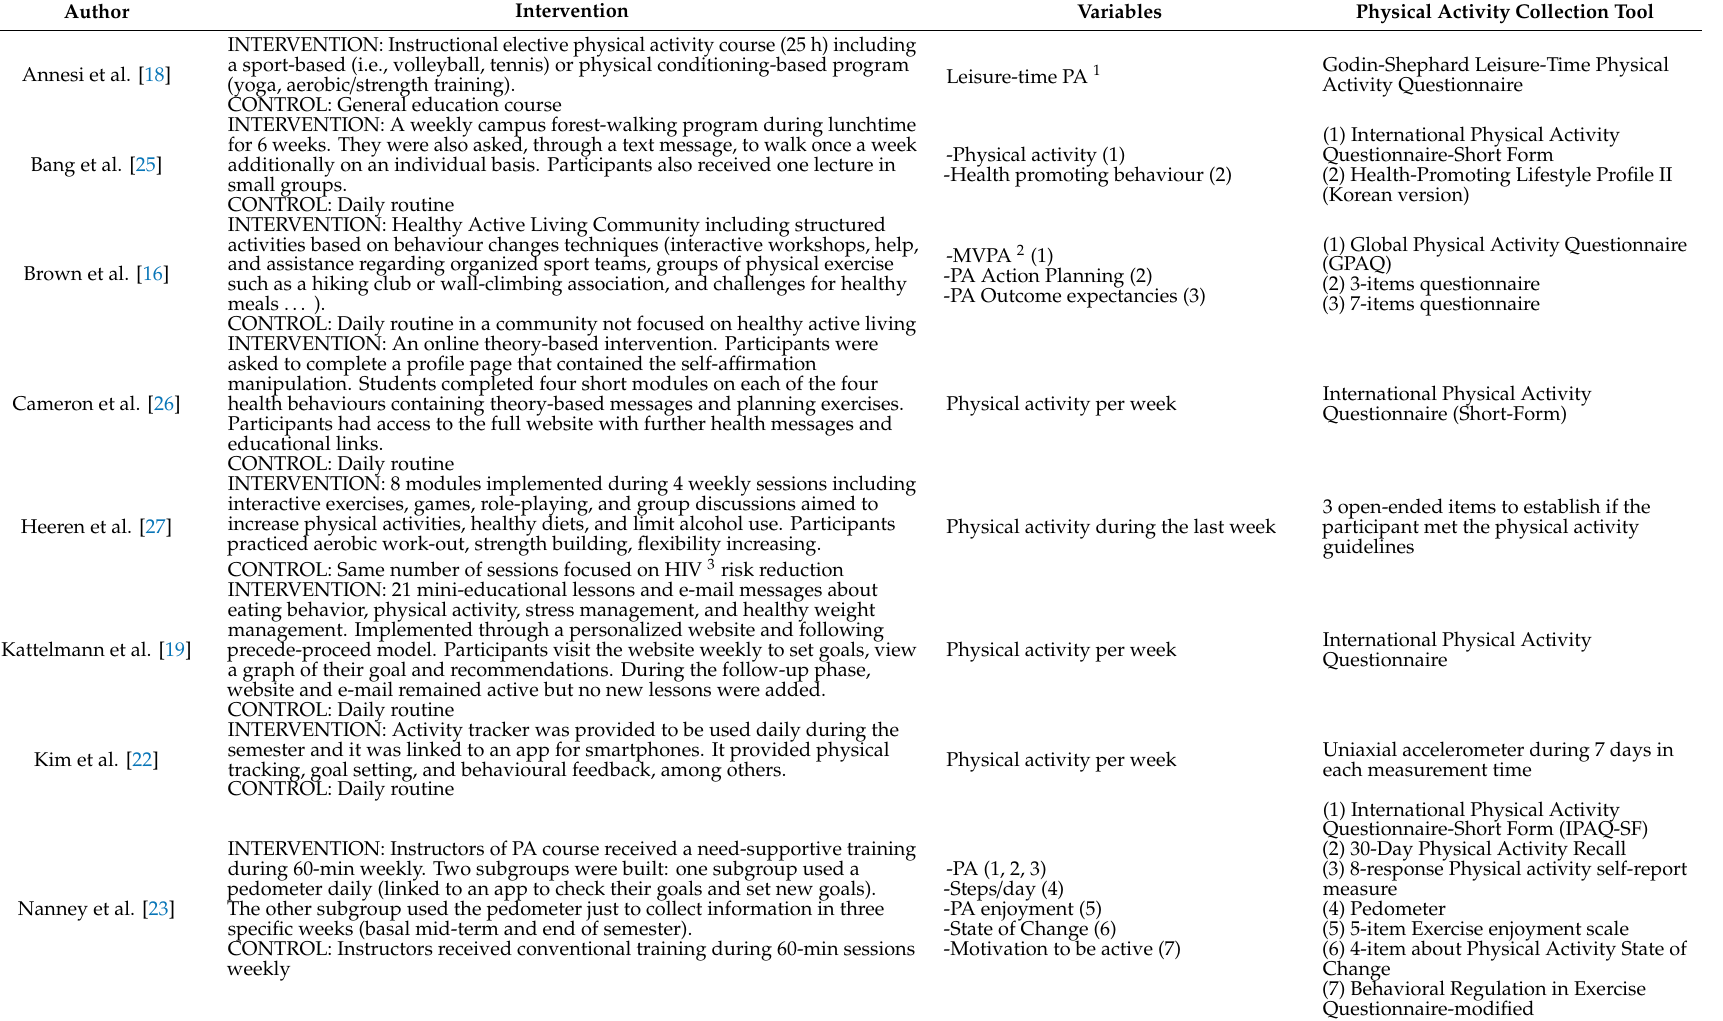
Table 2. Strategies implemented and data collection tools related to physical activity